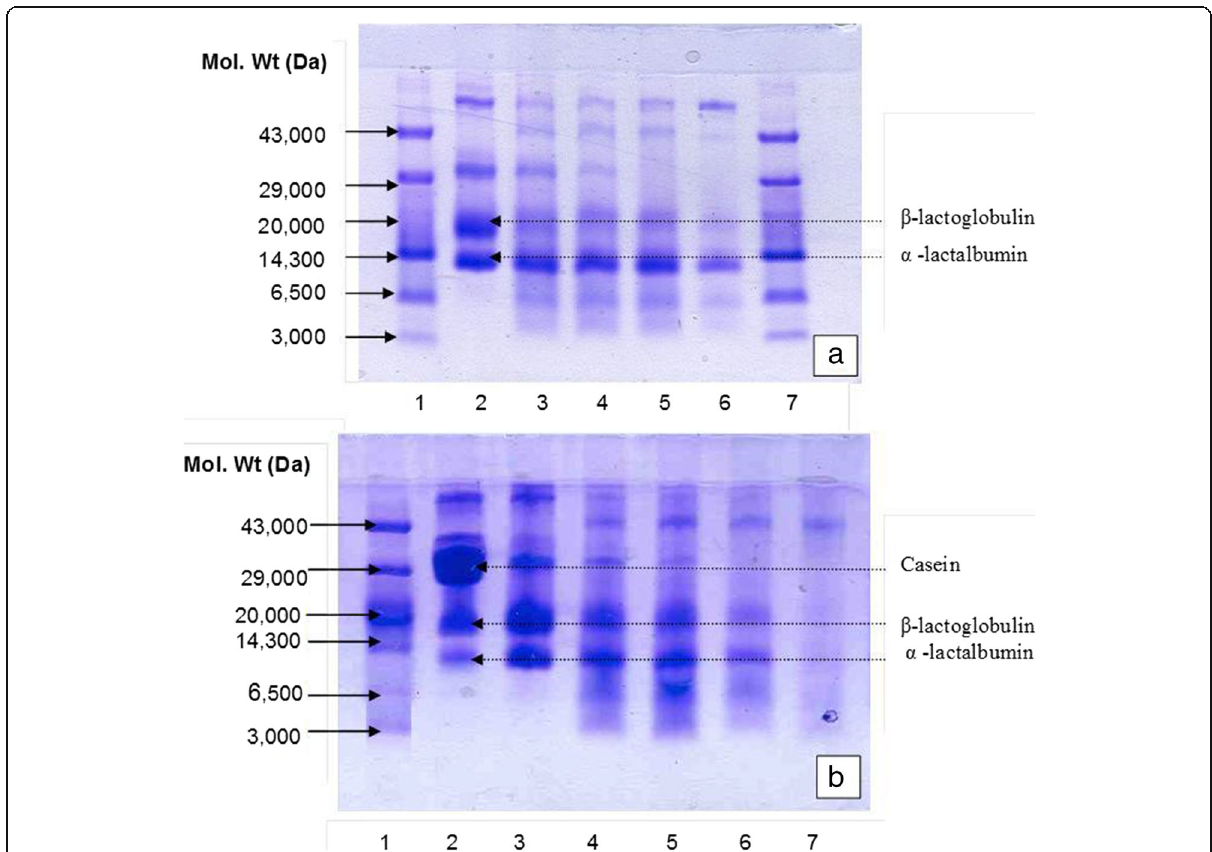
Fig. 1 a Tricine SDS-PAGE of hydrolyzates from 10% whey protein solution. Lane 1 - molecular weight standards; lane 2 - whole WPC; lane 3, 4, 5, 6 - hydrolyzates of DH 5, 7, 9, 11%, respectively; lane 7 - molecular weight standard b From 15% whey protein solution. Lane 1 - molecular weight standards; lane 2 - toned milk; lane 3 - whole WPC; lane 4, 5, 6, 7 - hydrolyzates of DH 5, 7, 9, 11%,